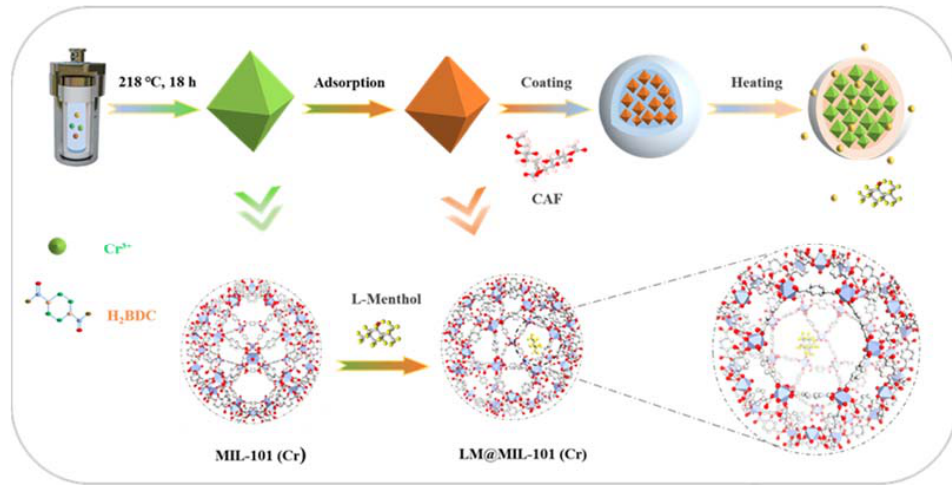
Scheme 1. Schematic diagram of encapsulation and release of